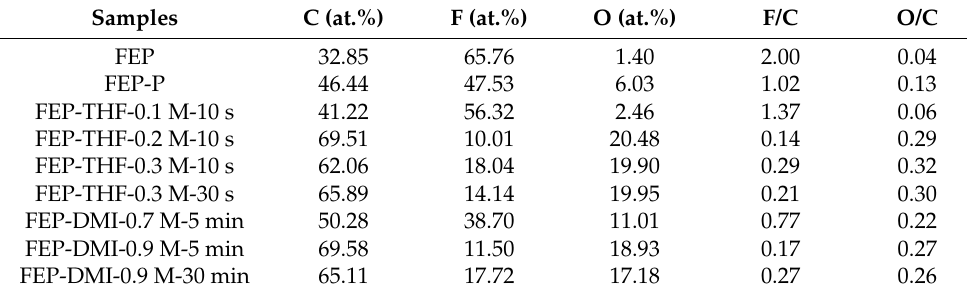
Table 1. XPS element content of the surface of FEP activated under different conditions.